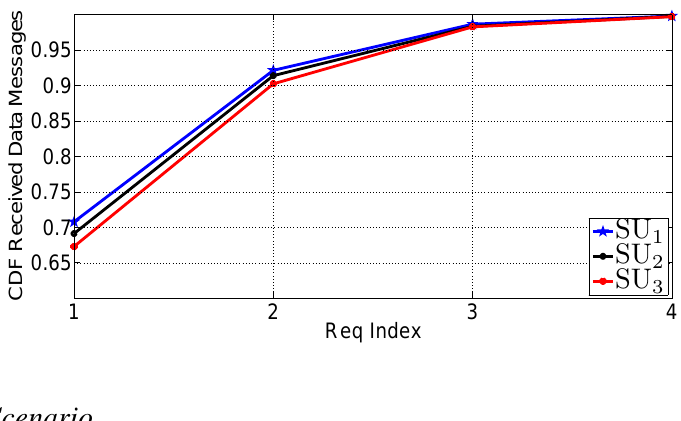
Figure 20. CDF of received DATA messages before REQUEST messages in Scenario